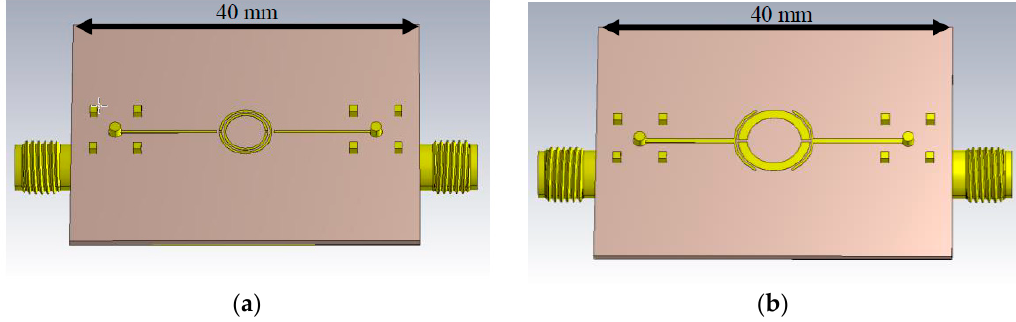
Figure 1. CST Microwave Studio models of the simulated split-ring resonators. ( a ) Double split-ring resonator; ( b ) Symmetrical split-ring resonator.